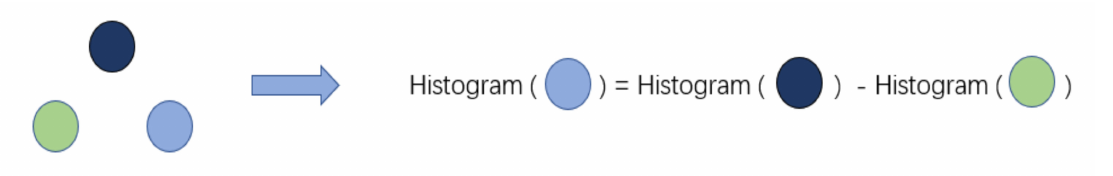
Figure 3. “Histogram difference acceleration” construction method.